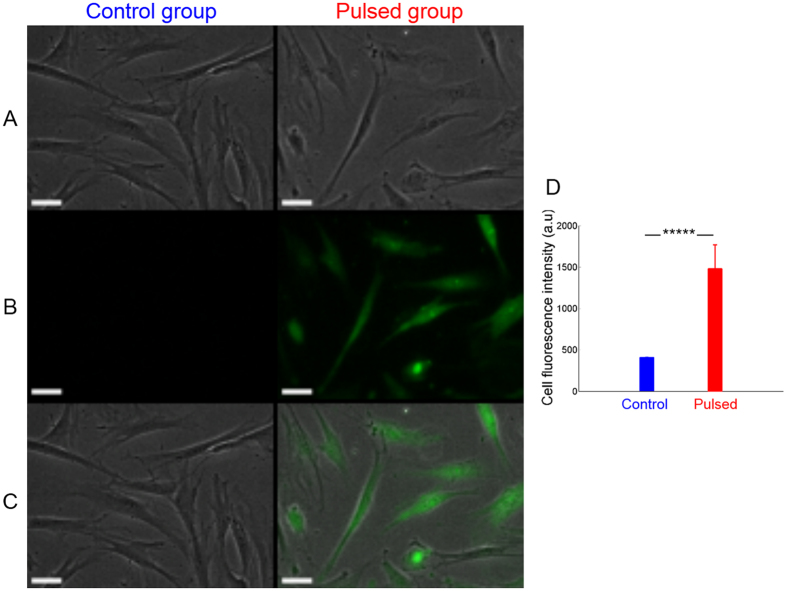
Bright-field and fluorescence microscopy images of control and pulsed haMSC cells.(A) – Bright-field images, (B) – Yo-Pro-1 fluorescence images, (C) – Combined images, (D) –Yo-Pro-1 fluorescence intensity into cells. Scale bar: 50 μm. The pulse conditions are 8 pulses, 100 μs, 1 000 V/cm and 1 Hz. The exposure time for fluorescence images was fixed to 200 ms. Images were taken 10 minutes after the delivery of pulsed electric fields. Student’s t-test: ****p-value ≤ 0.01%.